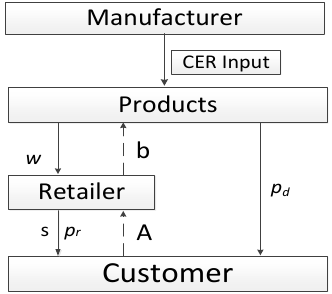
Figure 1. The low-carbon, closed-loop supply chain system.